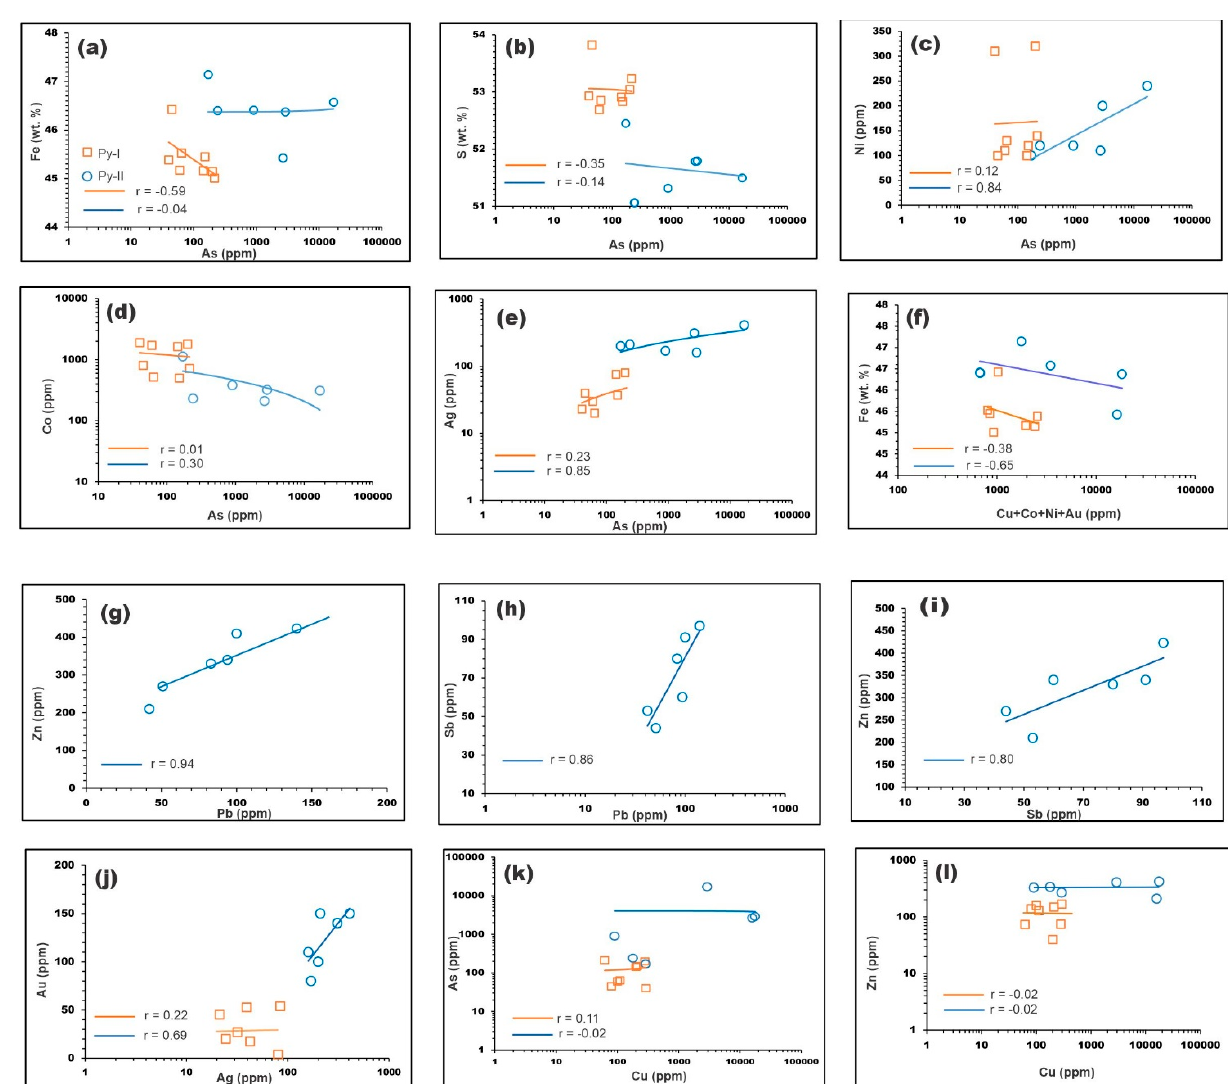
Figure 11. Binary plots of selected trace elements in pyrite using EPMA, demonstrating positive and negative correlations. ( a ) Fe/As; ( b ) S/As; ( c ) Ni/As; ( d ) Co/As; ( e ) Ag/As; ( f ) Fe/(Cu + Co + Ni + Au); ( g ) Zn/Pb; ( h ) Sb/Pb; ( i ) Zn/Sb; ( j ) Au/Ag; ( k ) As/Cu; ( l ) Zn/Cu.